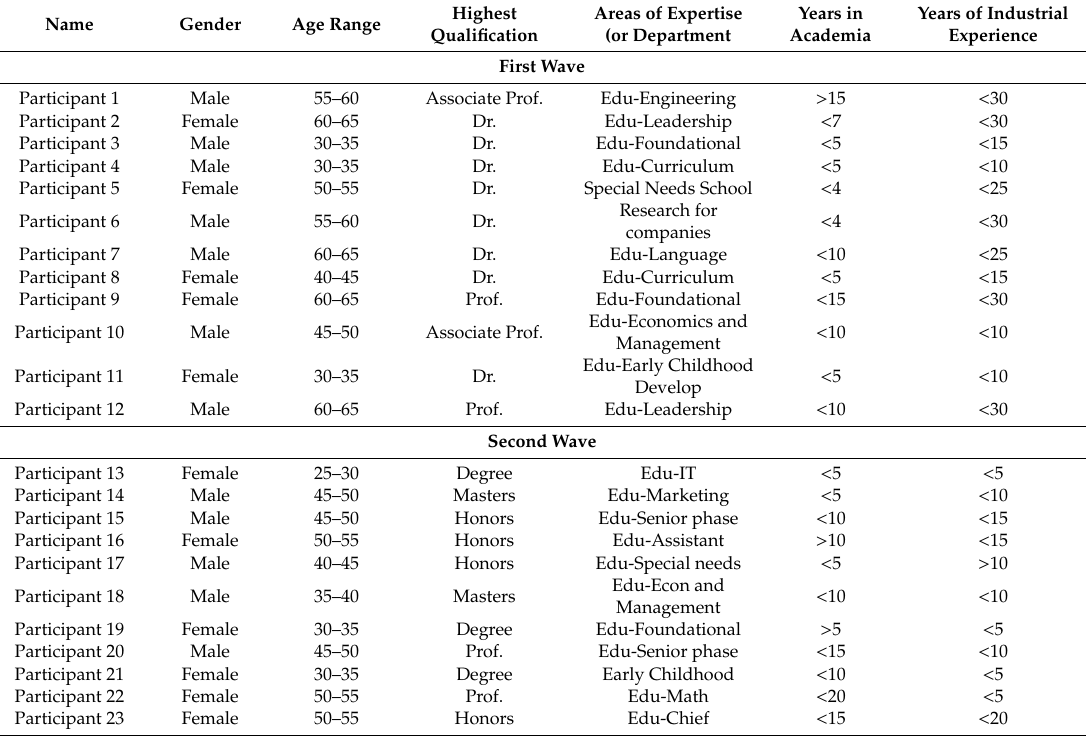
Table 2. Participants’